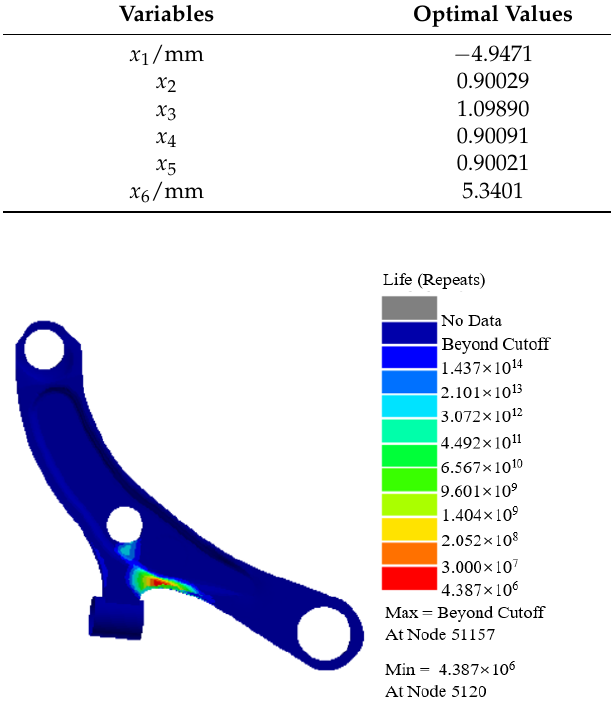
Figure 14. Fatigue life nephogram of optimized control arm.